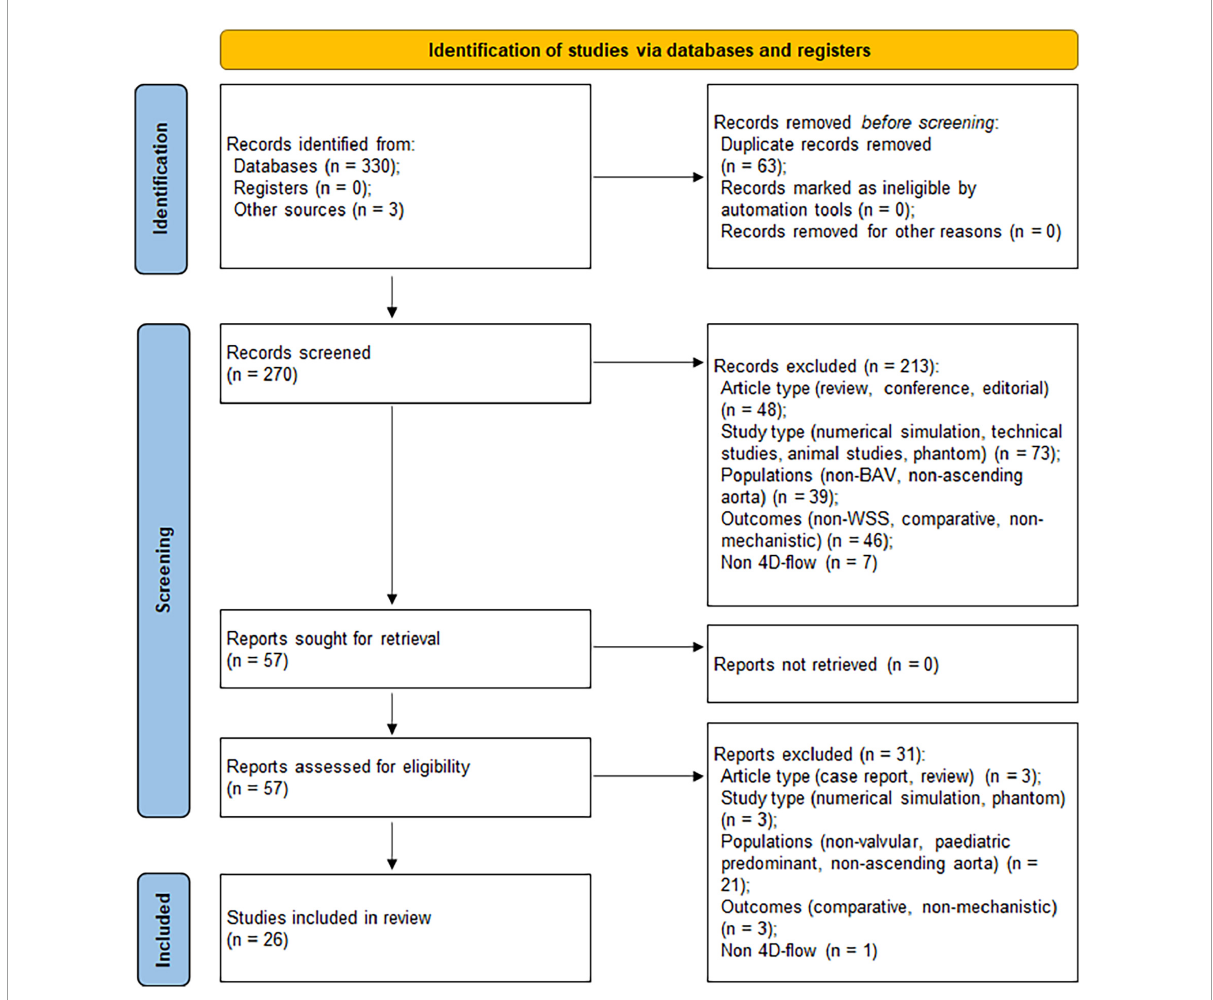
Frontiers in Cardiovascular